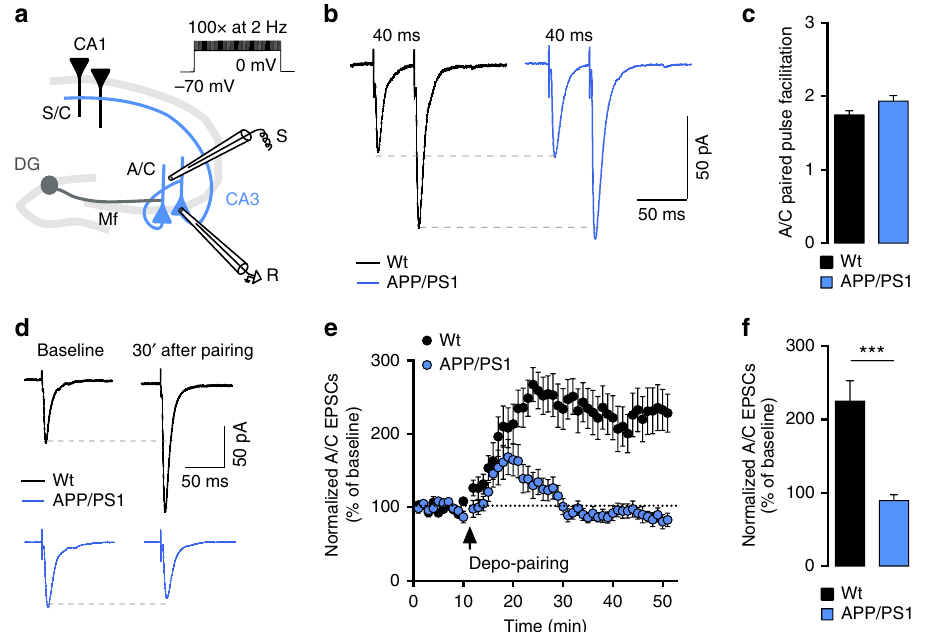
Figure 1 | Early synaptic alterations in 6-month-old APP/PS1 CA3 PCs. ( a ) Scheme illustrating the hippocampus with a recording electrode on a CA3 PC (R) and a stimulating electrode (S) in the stratum radiatum. Depo-pairing protocol used to trigger NMDAR-dependent LTP: depolarization of postsynaptic cell to 0mV paired with 100 stimuli at 2Hz frequency. ( b ) Example traces of paired-pulse responses (40ms interval, average of 5 sweeps) in cells from both genotypes. ( c ) Bar graph summarizing PPR values in wt ( n ¼ 21) and APP/PS1 mice ( n ¼ 25; P ¼ 0.054, unpaired t -test). ( d ) Sample traces representing average A/C-EPSCs 10min before and 30min after depo-pairing protocol. ( e ) Summary time course of normalized A/C-EPSCs in the experiments illustrated in d . ( f ) The robust LTP of A/C synapses found in 6-month-old wt mice ( n ¼ 12) is abolished in APP/PS1 mice ( n ¼ 11, *** P o 0.0001, unpaired t -test; Supplementary Table 1). Recordings were performed in the presence of 10 m M bicuculline and 3 m M CGP55845.